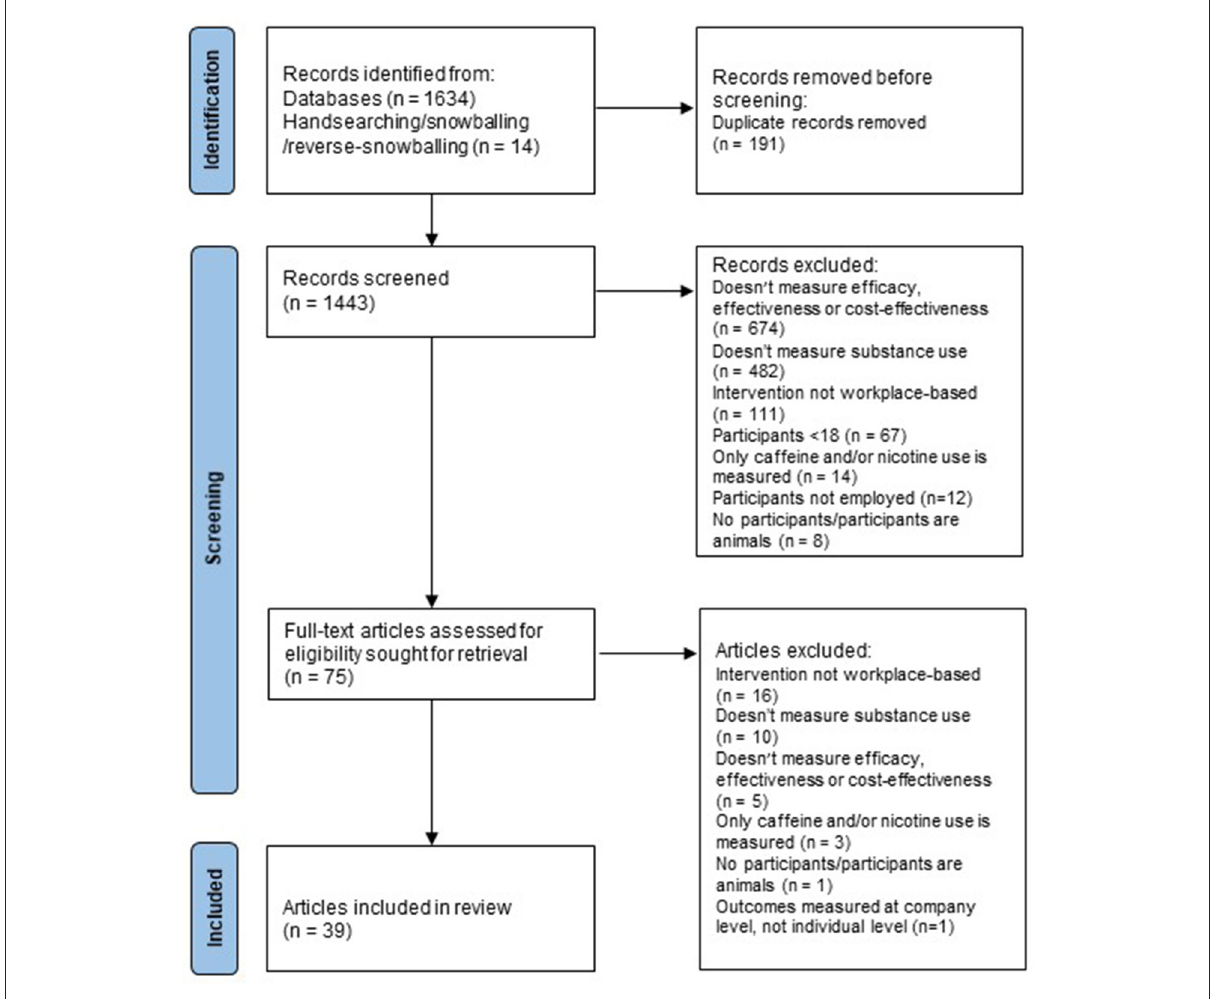
FIGURE1 PRISMA flow